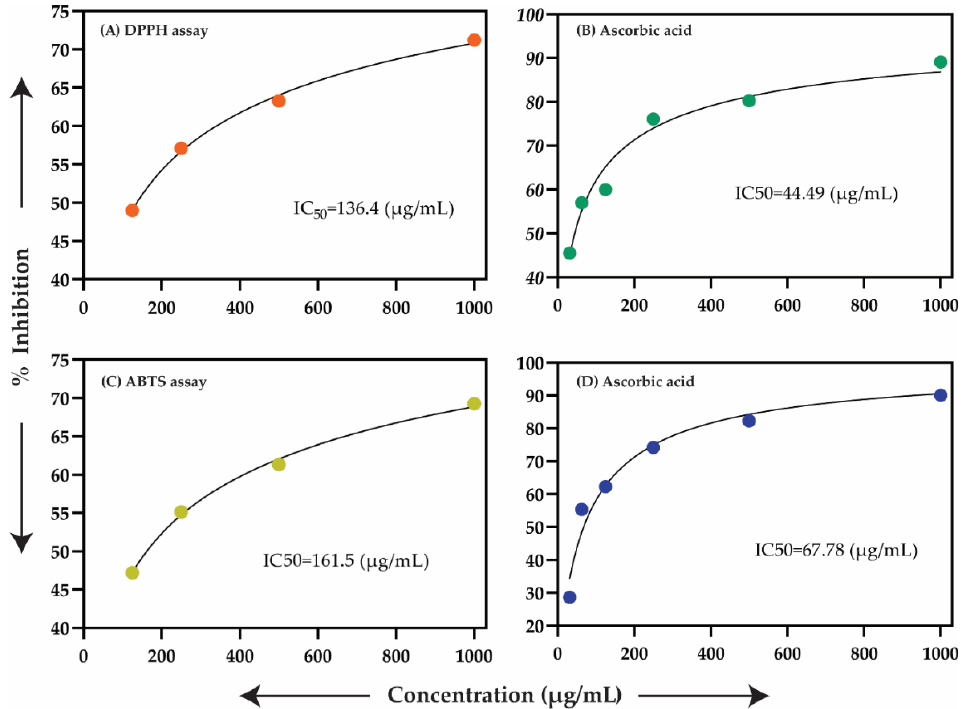
Figure 4. Antioxidant activity of oil of S. edelbergii where ( A ) represents the antioxidant activity of the oils of S. edelbergii ; ( B ) the potential of ascorbic acid (standard) using DPPH assay; ( C ) displays the antioxidant activity of the oils using ABTS assay; ( D ) the potential of ascorbic acid via ABTS assay .